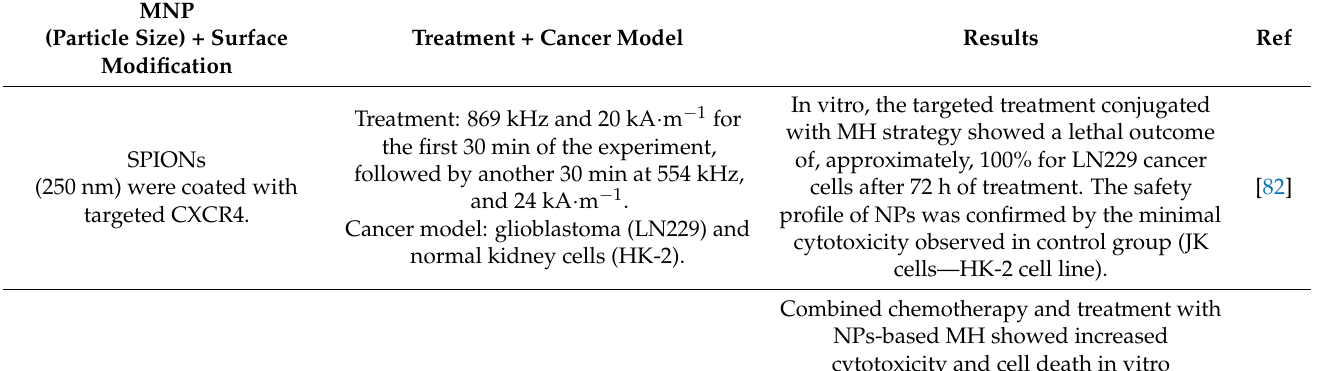
Table 1. Studies using magnetic nanoparticles (MNPs) for magnetic hyperthermia treatment in